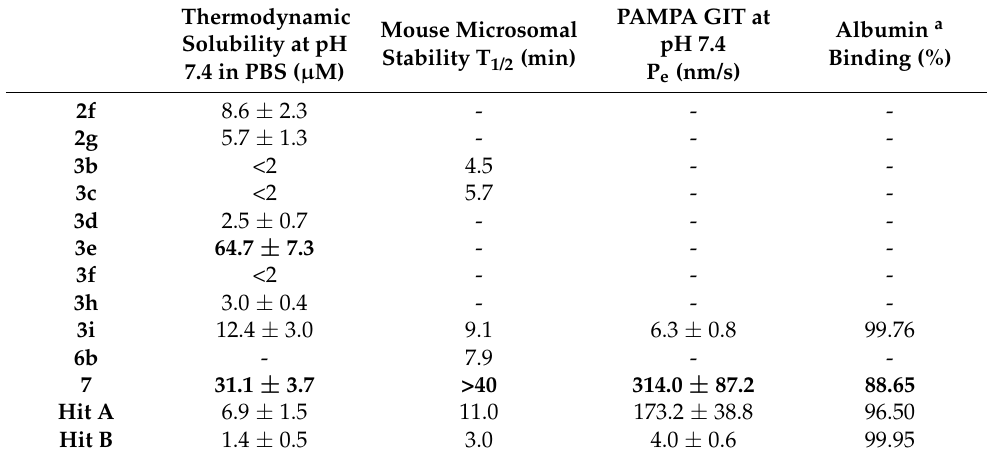
Table 4. In vitro physicochemical and pharmacokinetic properties of selected key